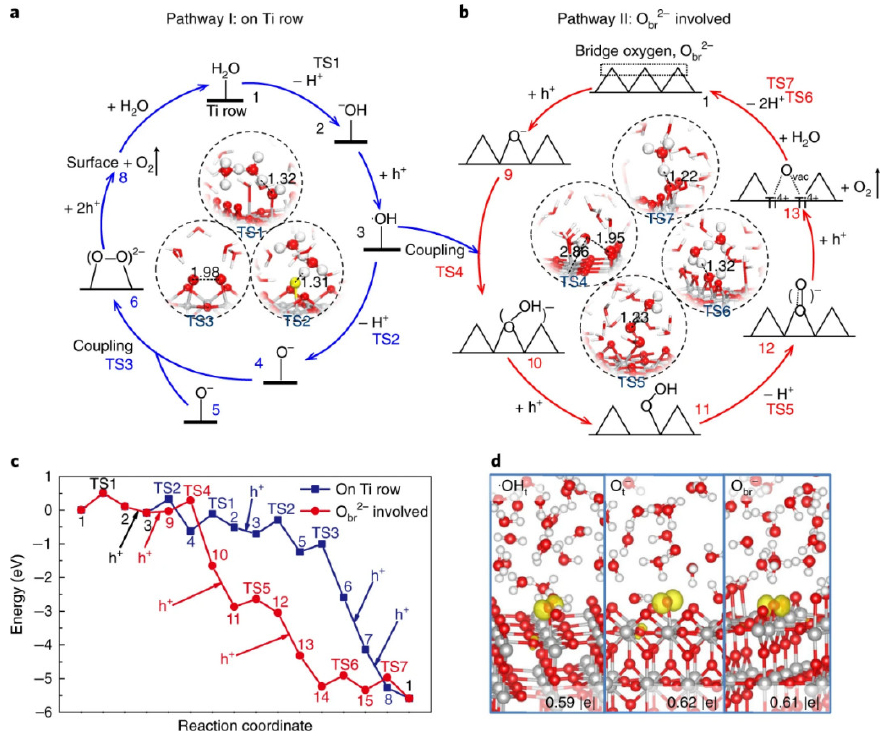
Figure 7. The photocatalytic energy profile diagram OER involving dual pathways of proposed mechanism. ( a ), Pathway I, the reaction pathway occurring on the Ti row. ( b ) Pathway II, the reaction involving bridge oxygen. The TS structures are shown in the insets., The states 1, 2, . . . , 15 correspond to the states in ( a , b ) in the energy profiles diagram of pathways I and II. ( c ) h + represents the involvement of holes in the elementary. ( d ) Spin-density plots showing the existence of three surface radicals (the O 2p orbital can be seen as a dumbbell shape with an iso-value of 0.005) and the Bader charge difference (~0.6 |e| signifies that after trapping h + the oxygen becomes +0.6 |e| positively charged with respect to the lattice oxygen of the bulk TiO 2 . (Reprinted from ref. [55] with permission from Nature Catalysis. Copyright © 2018, Nature).